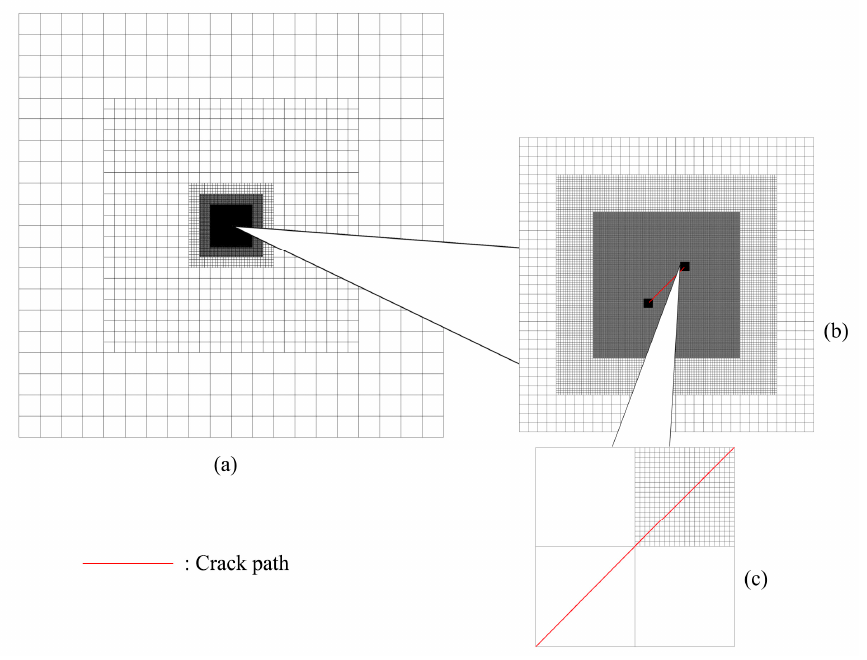
Figure 16. ( a ) Global mesh (in this view, the size of the largest element is 8 mm × 8 mm); ( b ) Mesh from the view of the 2nd-level refinement domain (in this view, the size of the largest element is 1 mm × 1 mm); ( c ) Comparison between the elements from the 5th-level refinement domain with the elements from the 4th-level refinement domain (in this view, the size of the largest element is 0.0625 mm × 0.0625 mm).